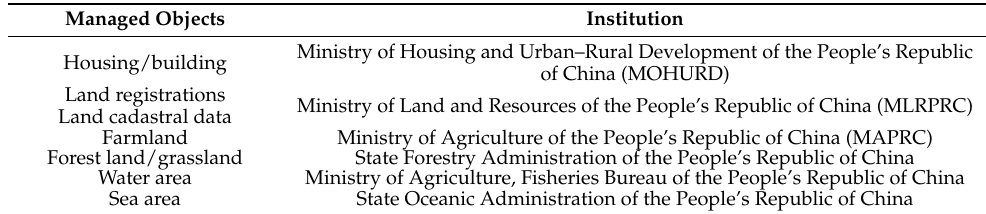
Table 1. Natural resource management institutions before